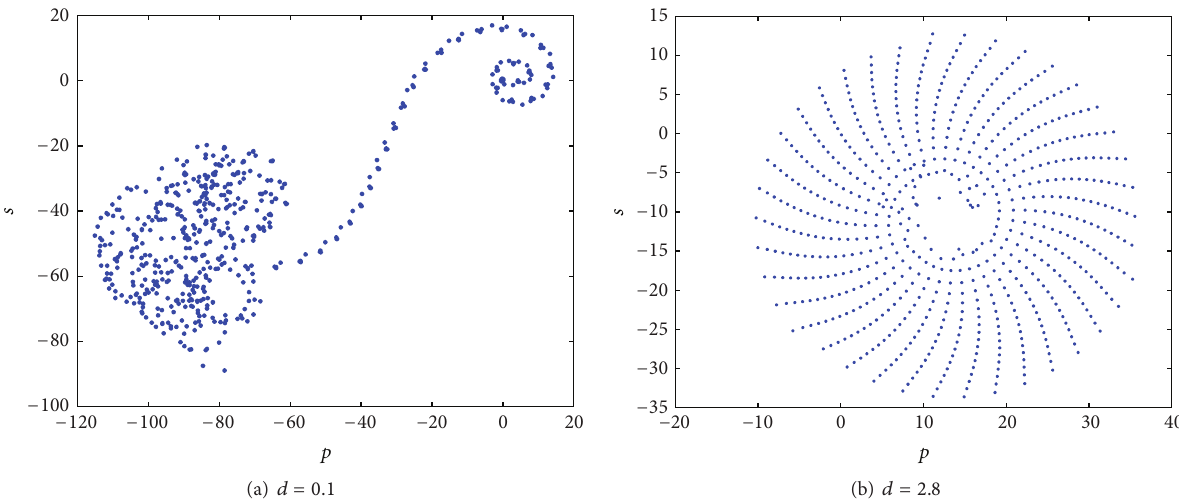
Figure 3: Plots in new coordinates (𝑝,𝑠) space with 𝑞 1 = 0.96 , 𝑞 2 = 0.94 , 𝑞 3 = 0.92 , 𝑞 4 = 0.78 , 𝑎 = 3 , 𝑏 = 0.4 , and 𝑐 = 0.4 .